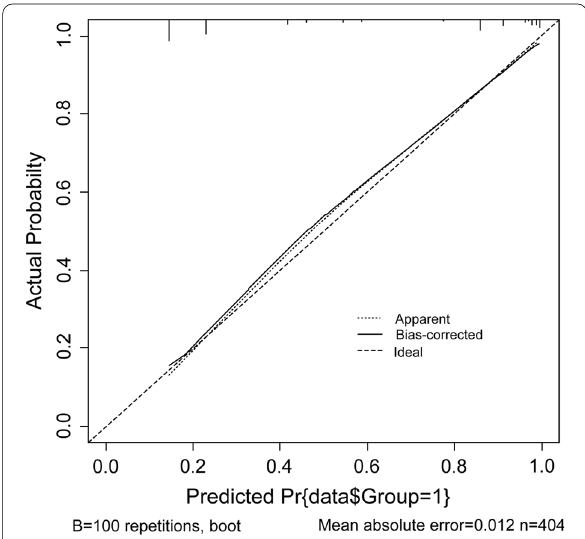
Fig. 8 Calibration curves for predicting the RR-DTC model. RR-DTC, radioiodine refractory differentiated thyroid